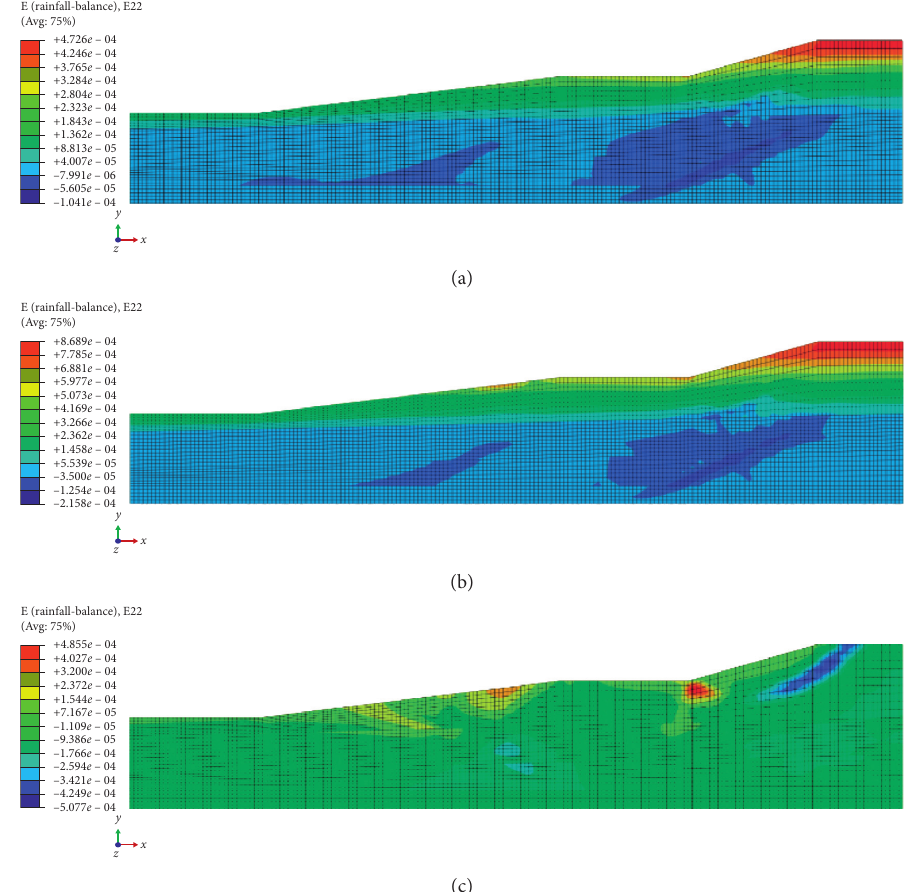
Figure 13: Distribution of vertical strain under different rainfall intensities. (a) Rainfall intensity is 40mm/d. (b) Rainfall intensity is 80mm/d. (c) Rainfall intensity is